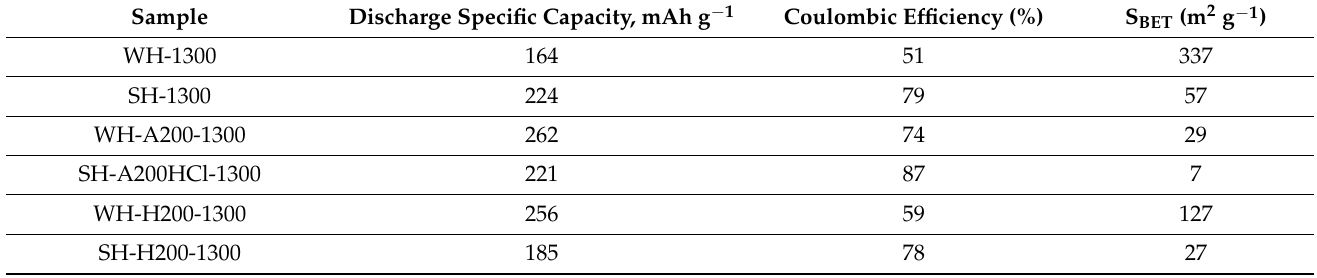
Table 1. Discharge specific capacity, Coulombic efficiency of the first cycle and BET specific surface area of HCs.